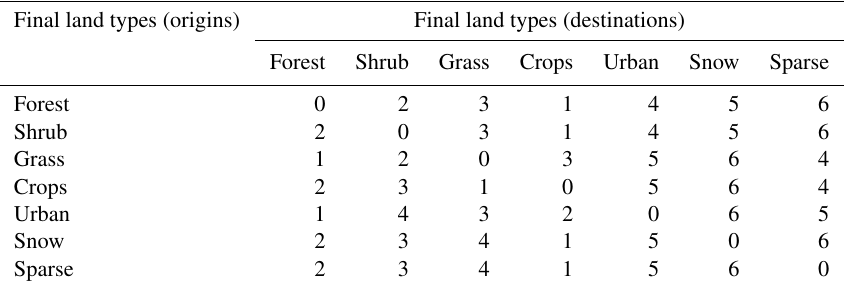
Table 1. Transition priorities by analyzing the 24-year global land cover records from the Land Cover CCI project of the European Space Agency Climate Change Initiative. The rows and columns represent the origins and destinations of the transitions, respectively. The smaller numbers indicate higher transition